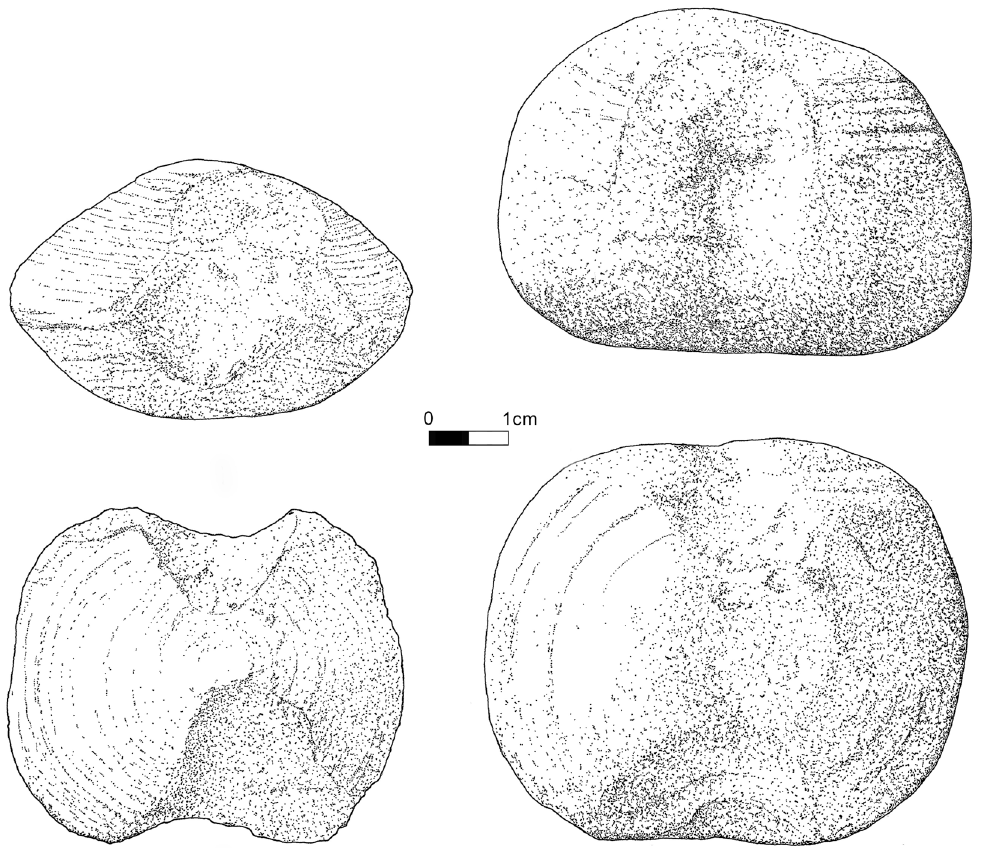
Figure 9. Drill bit of the “figure-of-eight” type, from the Lost City of the Pyramids project, Old Kingdom, Giza, Egypt (Tavares 2009:4, courtesy M.